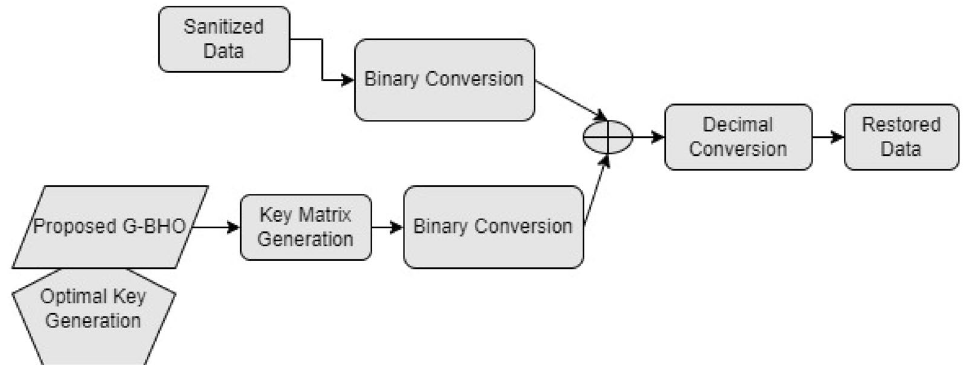
Figure 5. Data restoration